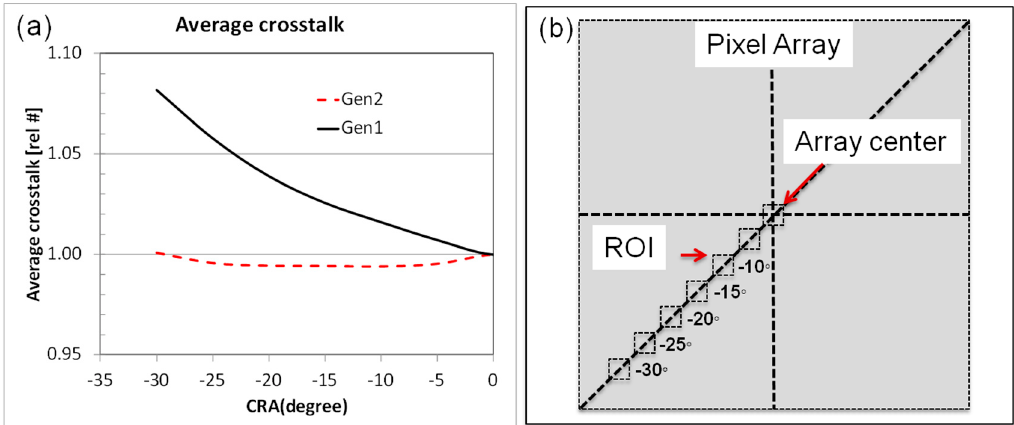
Figure 5. ( a ) Crosstalk vs angle, calculated from QE curves measured in a fix ROI along a diagonal as shown in the ( b ). Angles are the CRA of the module lens at each ROI.